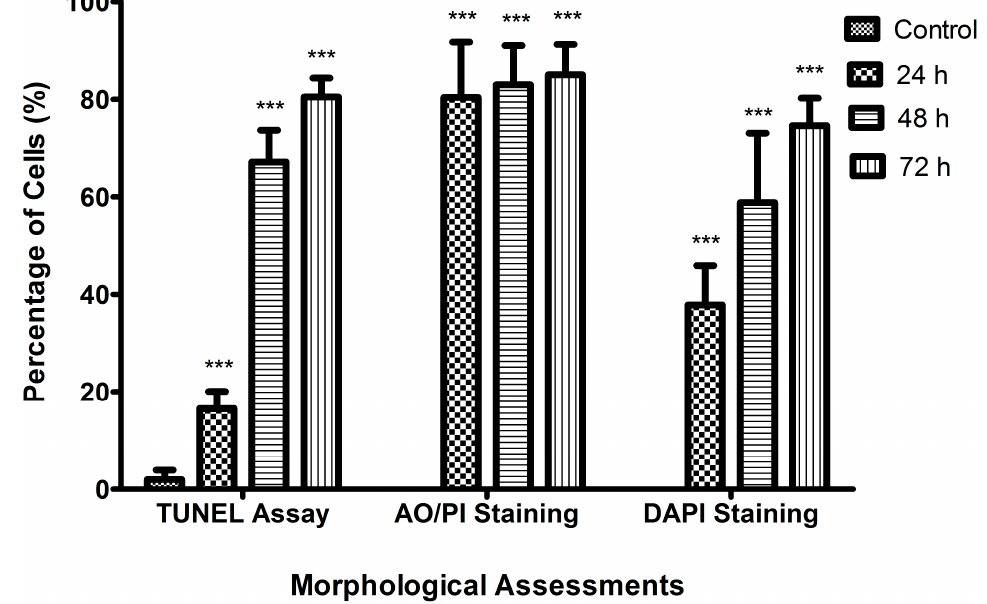
Figure 5. Bar graph showing the effect of raphasatin on apoptosis assessed using TUNEL, AO/PI, and DAPI in the MCF-7 cells. The cells were treated with 9.84 µM (IC 50 ) concentration of raphasatin for 24 h, 48 h, and 72 h, and compared with the untreated cells. Data are expressed in mean ± standard deviation (SD). *** p < 0.001.